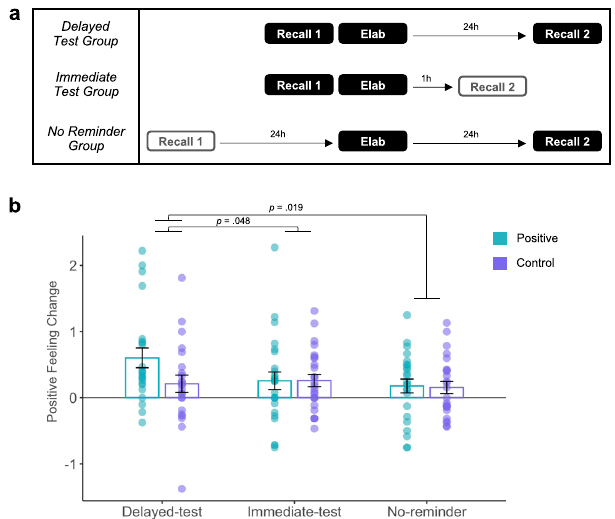
Fig. 4 Positive meaning fi nding leverages reconsolidation update mechanisms. Experiment 3: a Timeline; Recall 1 serves as reactivation,